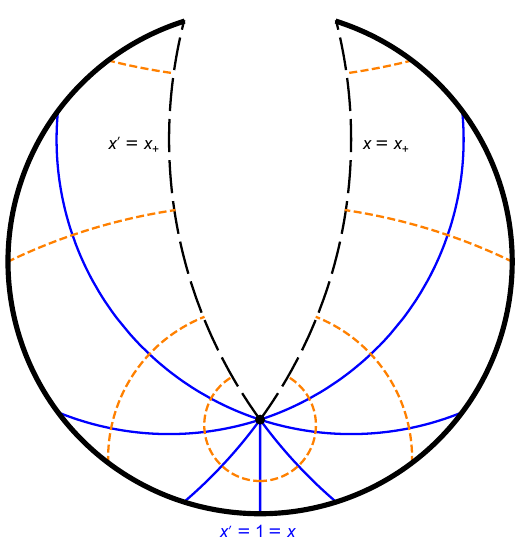
Figure 10 . The slowly accelerating conical deficit with A = 0 . 9 ‘ , pushed by a strut, mapped onto the Poincaré disk. The deficit is shown as a black point and accellerates southwards. A “wedge” is removed from the global space, with its edges x = x + and x 0 = x + (long-dashed black) identified to attain a wall. Several lines of constant x are shown in blue, with lines of constant y in dashed